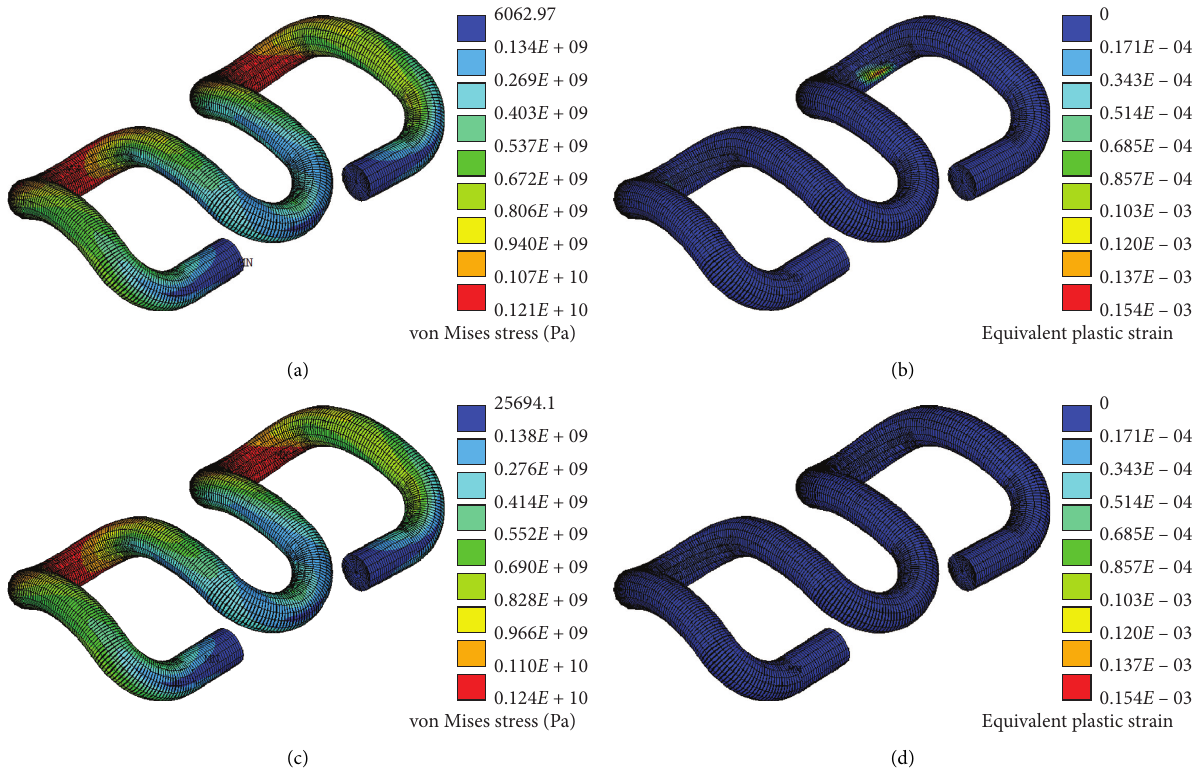
Figure 3: Contour plots under a normal installation state: (a) von Mises stress contour plot of 38Si7 elastic rail clip; (b) equivalent plastic strain contour plot of 38Si7 elastic rail clip; (c) von Mises stress contour plot of 60Si2Mn elastic rail clip; (d) equivalent plastic strain contour plot of 60Si2Mn elastic rail